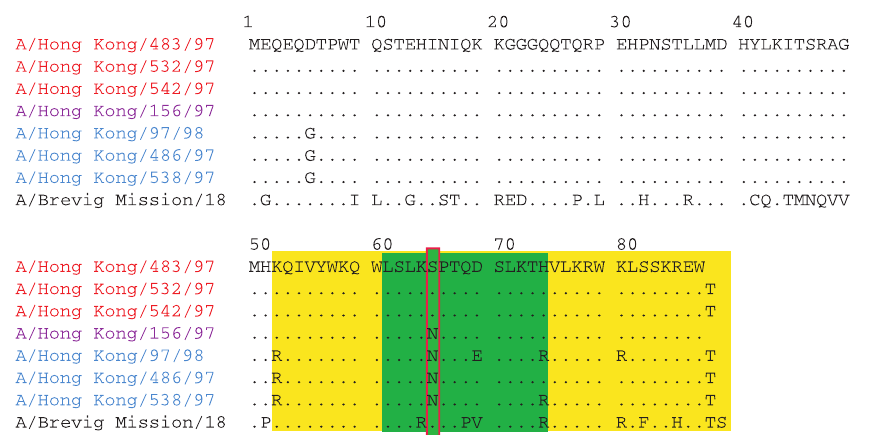
Figure 1. Alignment and Location of N66S Mutation in the PB1-F2 Protein Alignment of human isolates of influenza A viruses from a H5N1 Hong Kong outbreak and from the 1918 H1N1 pandemic. Viruses in red are of the high- pathogenic phenotype, those in purple are of intermediate pathogenicity, and those in blue are of low pathogenicity in mice. Yellow indicates C- terminal region with a -helical structure, and green indicates the minimal mitochondrial targeting sequence.